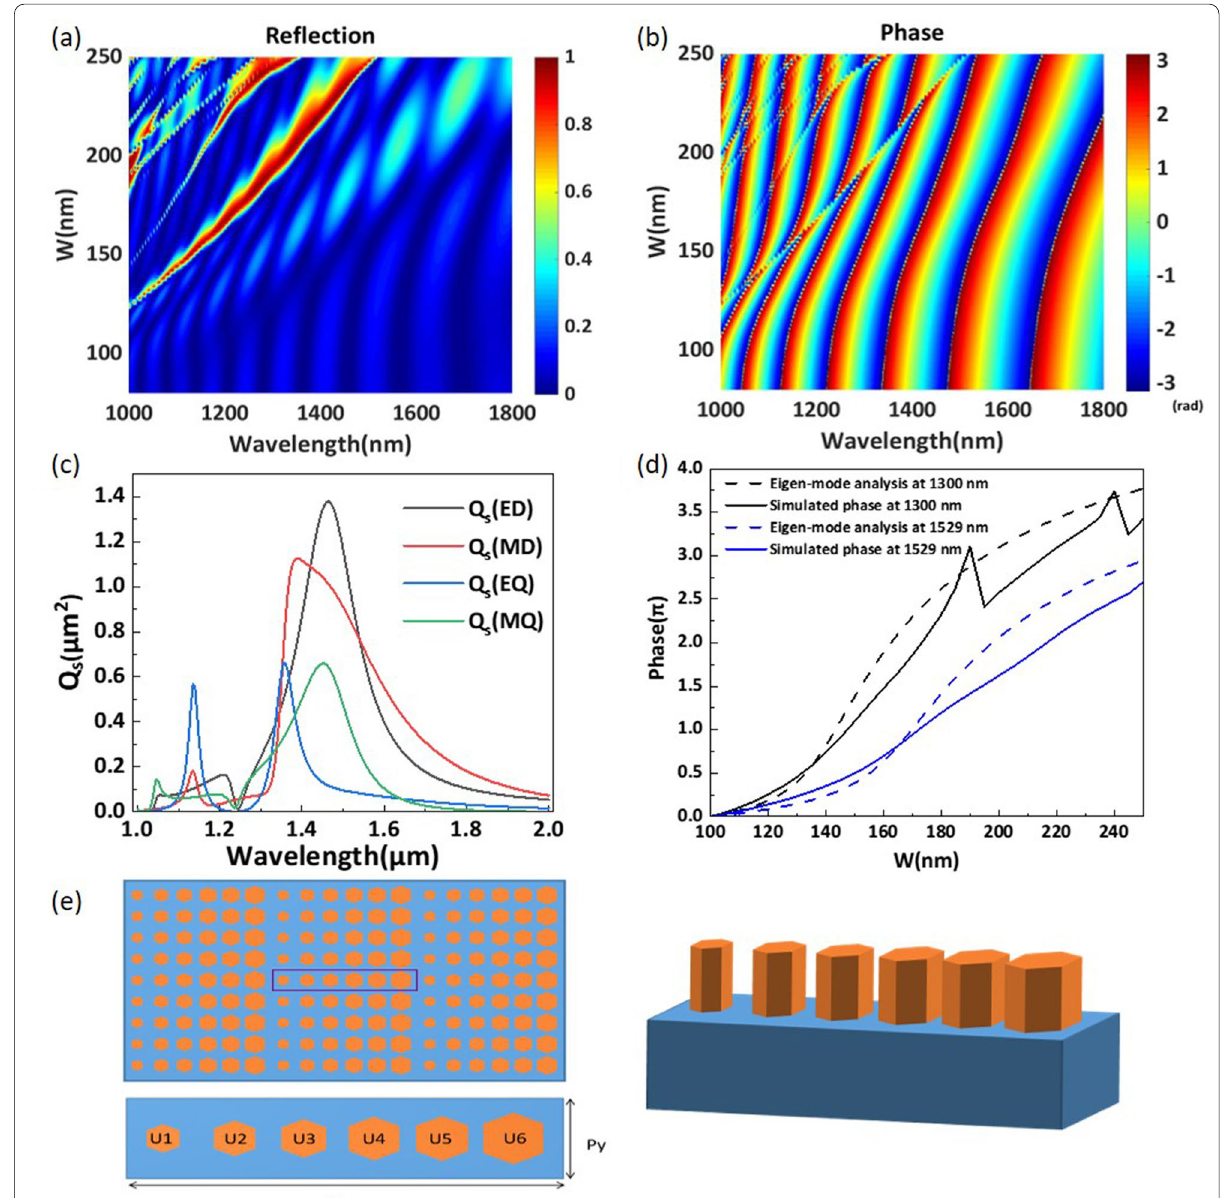
Fig. 3 a The reflection efficiency and b the phase of the periodic regular hexagonal nanorods for different values of w in the wavelength range of to the Mie expansion is shown. d Phase profiles obtained via eigenmode analysis and numerical simulations for varying side length w . e Schematic of the designed phase-gradient